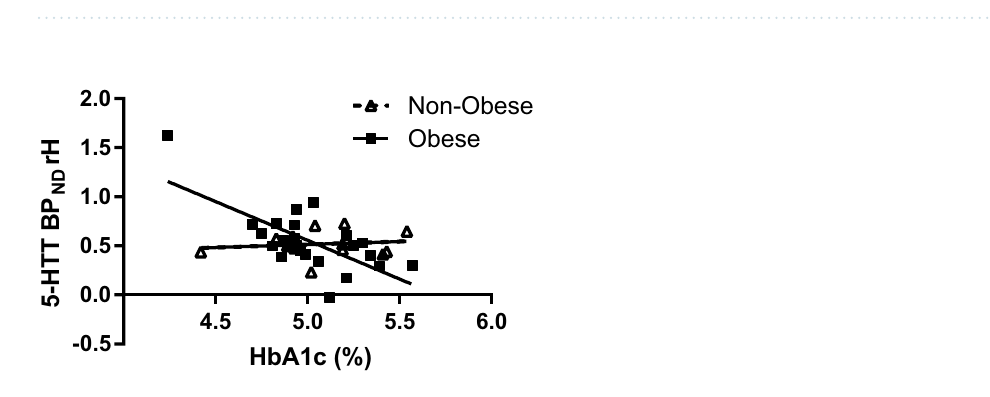
Figure 1. Scatterplot showing Pearson correlation between HbA1c levels and 5-HTT BP ND obtained with [ 11 C] DASB and PET in right hippocampus (rH) for obese (r = − 0.79, p = 0.0002) and non-obese (r = 0.06, p = 0.64). The difference of regression coefficients was significant (p =